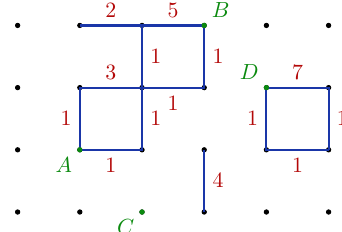
Figure 4: An example of a closed current corresponding to the closed HT graph from Fig. 3. Only the bonds for which n ( b ) (cid:54) = 0 are shown. According to the definition in the text, n connects vertices A , B but not A , C or A , D